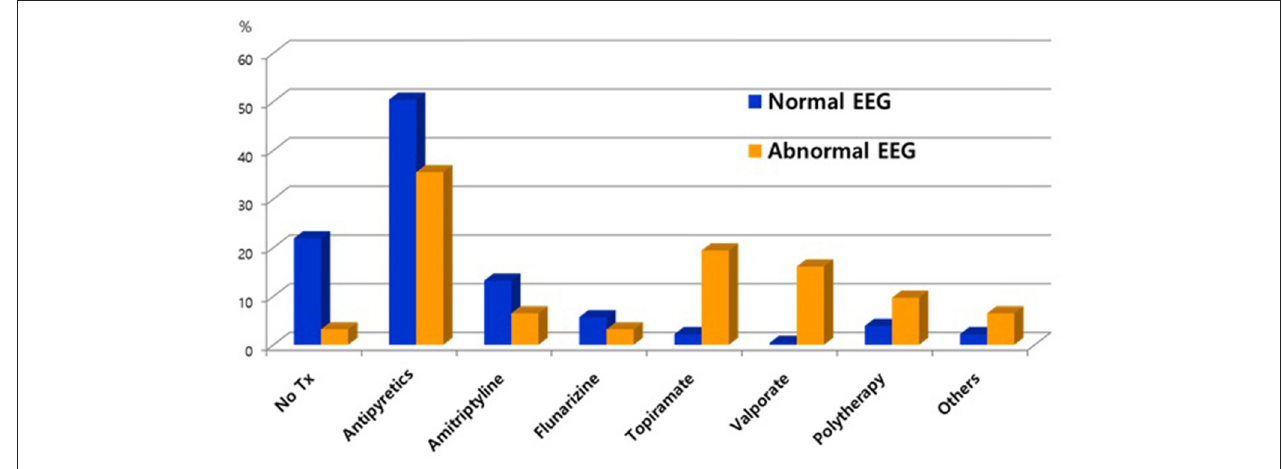
FIGURE 3 | Comparison of preventive therapy between patients with normal electroencephalograms (EEG) and epileptiform